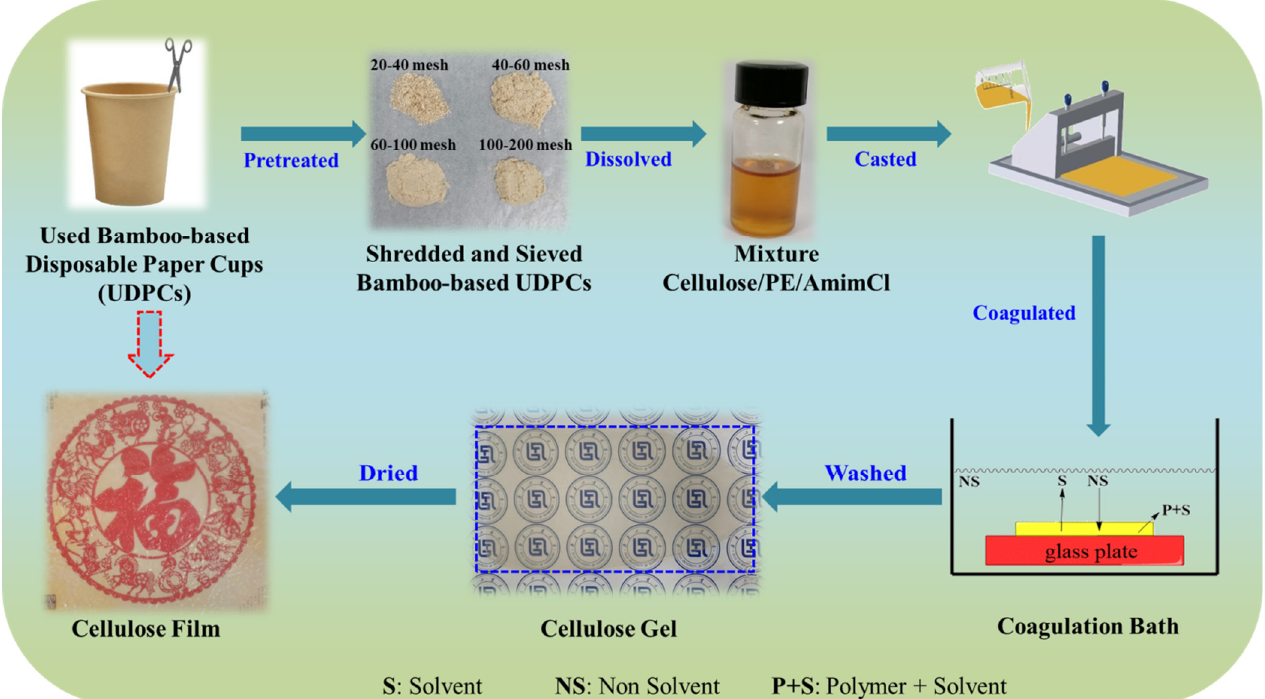
Figure 1. The processes for the dissolution of used bamboo-based disposable paper cups and the preparation of cellulose/polyethylene composite gels and films.